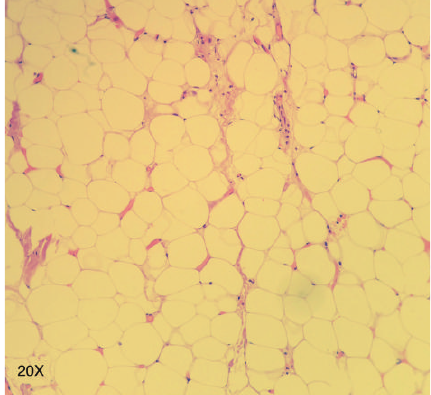
Figure 4: Histology. Hematoxylin-eosin stain (20x). Mature adipocytes and connective tissue cells with an elongated